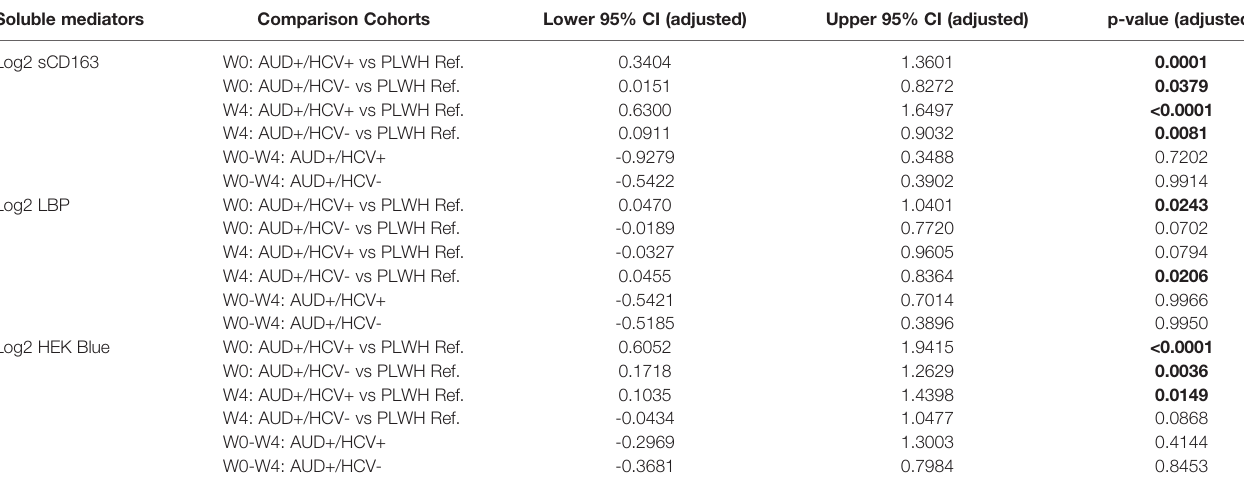
TABLE 2 | Signi fi cant differences in soluble mediators of in fl ammation between PLWH with and without AUD by HCV co-infection. Soluble